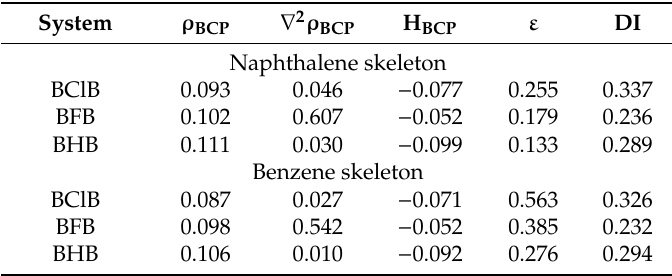
Table 2. Topological (au) parameters corresponding to the MP2 / aug-cc-pVTZ optimizations; electron density at BCP, ρ BCP ; its Laplacian, ∇ 2 ρ BCP ; the total electron energy density at BCP, H BCP ; the ellipticity, ε ; and the delocalization index, DI. These parameters for both H / X ... B contacts in the complex considered were equal or almost equal. In the latter case, mean values are shown.